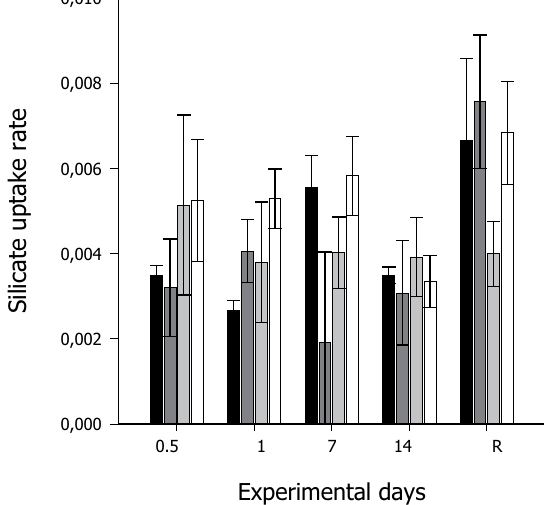
Figure 4. Mean net silicate uptake rate ( μ mol SiO 4 4 − g(tissue DW) − 1 h − 1 ) ± S.E. (n = 5) by G. barretti explants exposed to four different temperature levels (7 °C–Black bar, 9 °C–Dark grey bar, 11 °C–Light grey bar & 12 °C– White bar) over a 14 d experimental period. R on the x-axis is respiration at 65 d post exposure (the recovery period), with explants being maintained at ambient temperatures (7 °C) after the 14 d experimental period, irrespective of prior temperature exposure.